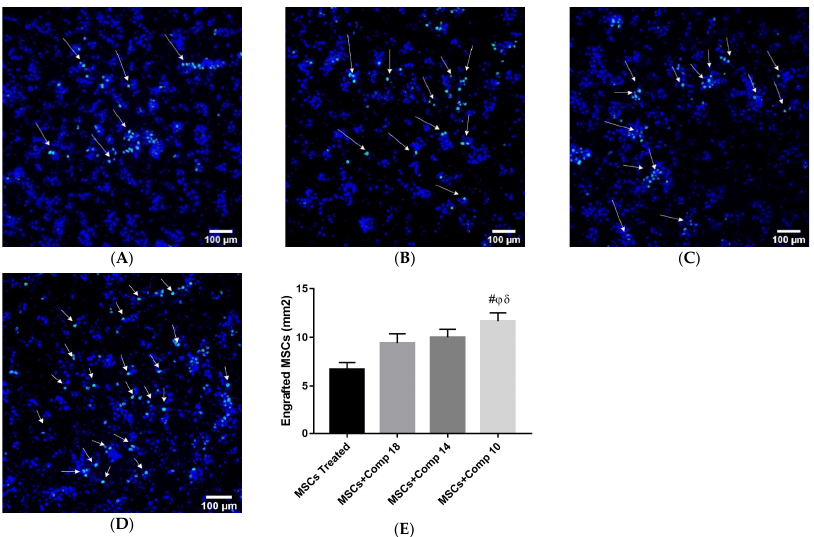
Figure 5. MSCs homing in injured liver 15 days post ‐ transplantation: ( A ) injured liver with MSCs transplantation; ( B ) injured liver subjected to combined treatment MSCs + compound ( 18 ); ( C ) MSCs + compounds ( 14 ); ( D ) MSCs + compounds ( 10 ); ( E ) engrafted cells quantification in different experimental models. (100×; scale bar: 100uM). Bars along with different symbols show significance with each other at p < 0.05. # p < 0.05 for MSCs + Comp10 vs. MSCs; φ p < 0.05 for MSCs + Comp10 vs. MSCs + Comp18; δ p < 0.05 for MSCs + Comp10 vs. MSCs + Comp14.